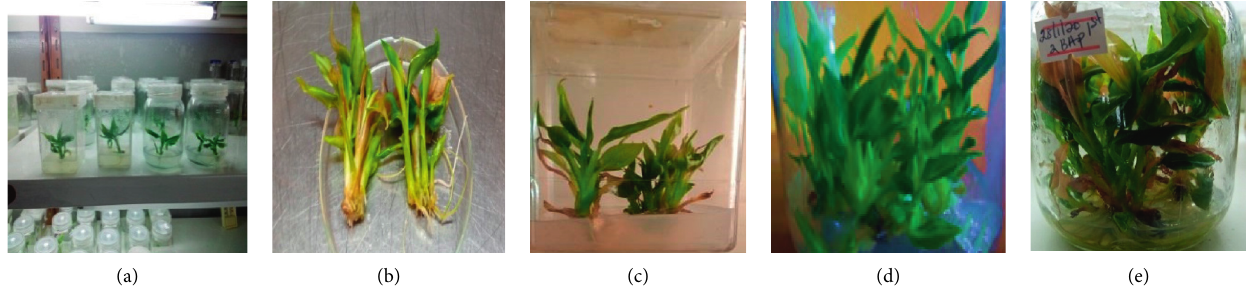
Figure 3: In vitro shoot multiplication of korarima: (a) microshoots cultured on shoot multiplication medium; (b) shoots proliferated on the MS medium containing 1.5mg/l BAP after four weeks; (c) shoots proliferated on the MS medium containing 2.0mg/l BAP after four weeks; (d) shoots proliferated on the MS medium containing 1.5mg/l BAP after the second subculture, that is, 9 weeks; (e) shoots proliferated on the MS medium containing 2mg/l BAP after the second subculture, that is, 9 weeks. Bars � 1 cm. Table 8: Effect of BAP, TDZ, KN, and BAP ∗ IBA on in vitro shoot multiplication of korarima. BAP